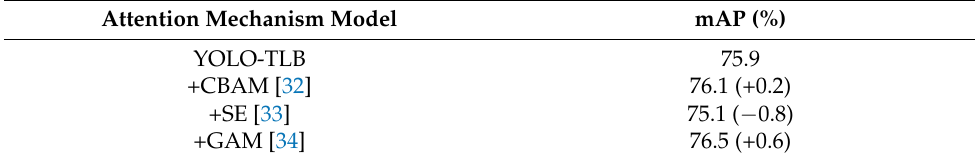
Table 5. Results of different attention mechanisms.